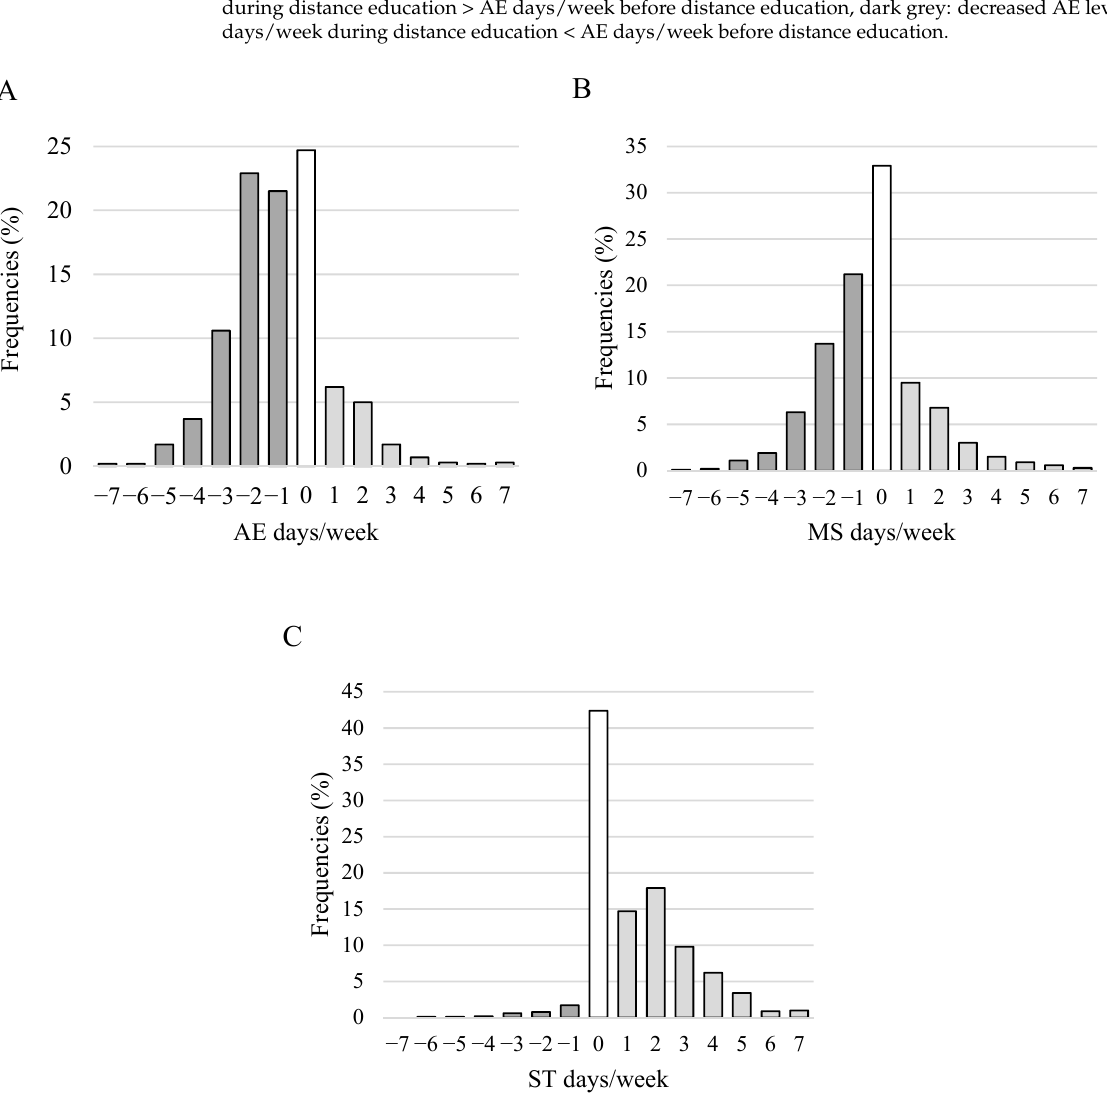
Notes. AE: the level of aerobic exercise means the number of days/week doing aerobic exercise * Do not do AE during and before distance education, bold: no changes in the level of exercise, i.e., AE days/week during (Table 2). A total of 55% of students were doing one to three days less AE per week during distance education as before (see Figure 2A). days/week during distance education < AE days/week before distance education.